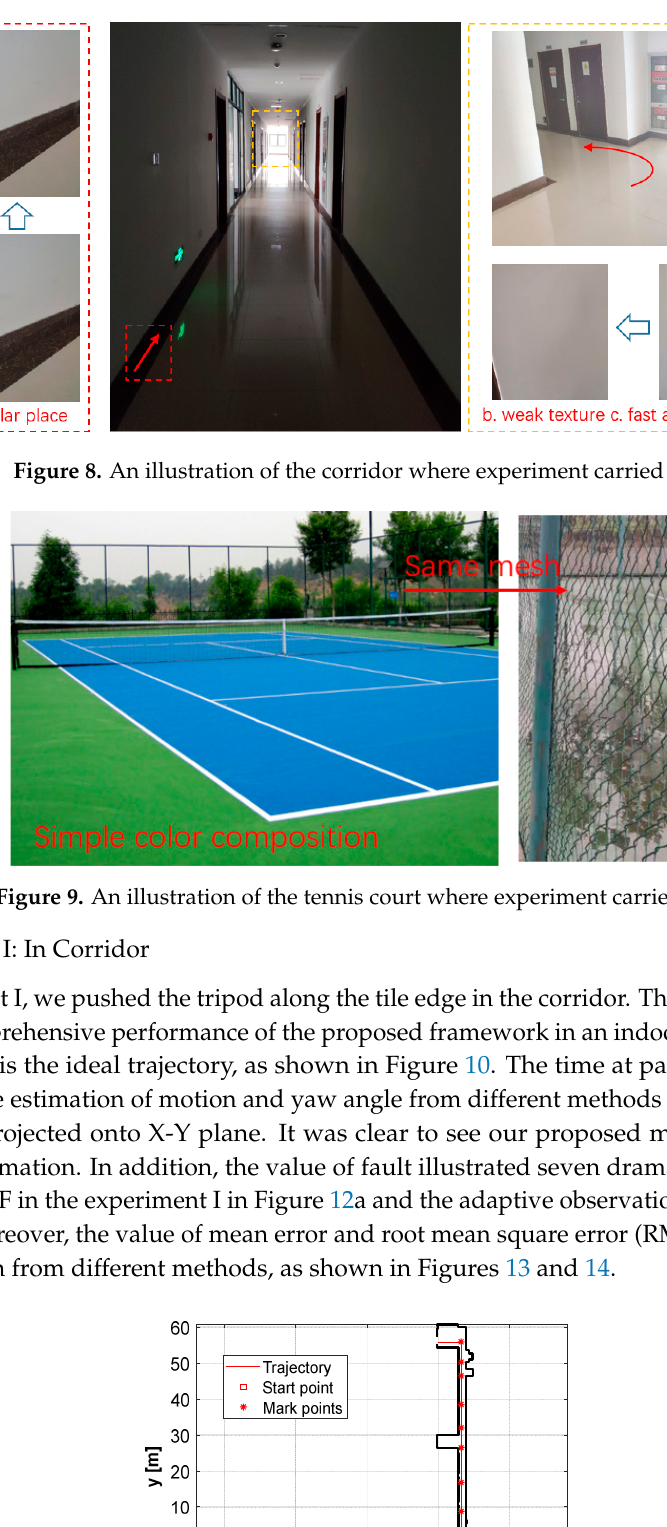
Figure 10. An illustration on the corridor plan, the ideal trajectory, and markers.